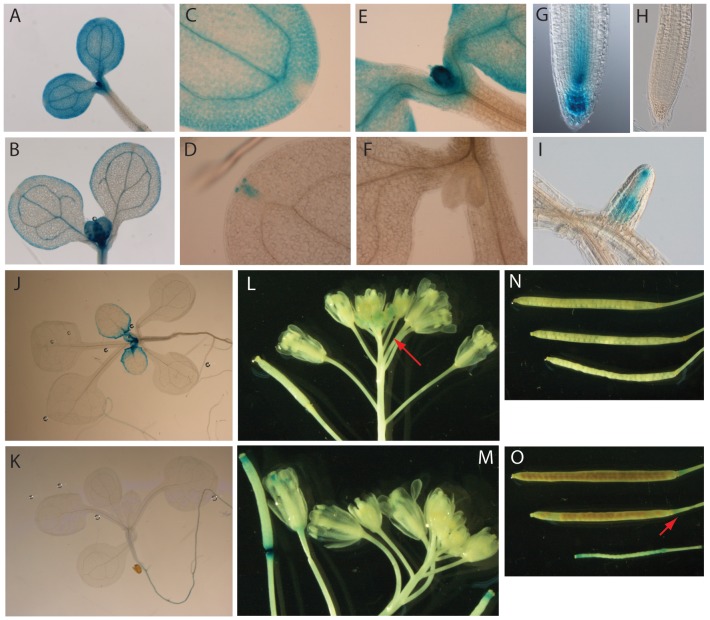
Overview or TIFY8 and JAZ1 promoter gene expression.GUS stains of Arabidopsis plants expressing either TIFY8 or JAZ1 promoter fusions to GUS and GFP. A, B. TIFY8 promoter expression pattern in 5 and 7 day-old seedlings, respectively. C, D. TIFY8 (C) and JAZ1 (D) promoter expression in 5 day-old cotyledons. E, F.
TIFY8 (E) and JAZ1 (F) promoter expression in the shoot apical meristem and emerging leaves of 5 day-old seedlings. G, H. TIFY8 (G) and JAZ1 (H) promoter expression in the root tip of 5 day-old Arabidopsis seedlings. I.
TIFY8 promoter expression in lateral root of a 10 day-old seedling. J, K.
TIFY8 (J) and JAZ1 (K) promoter expression in 14 day-old seedlings. L–O. TIFY8 and JAZ1 promoter expression in flowers (L, M) and siliques (N, O).